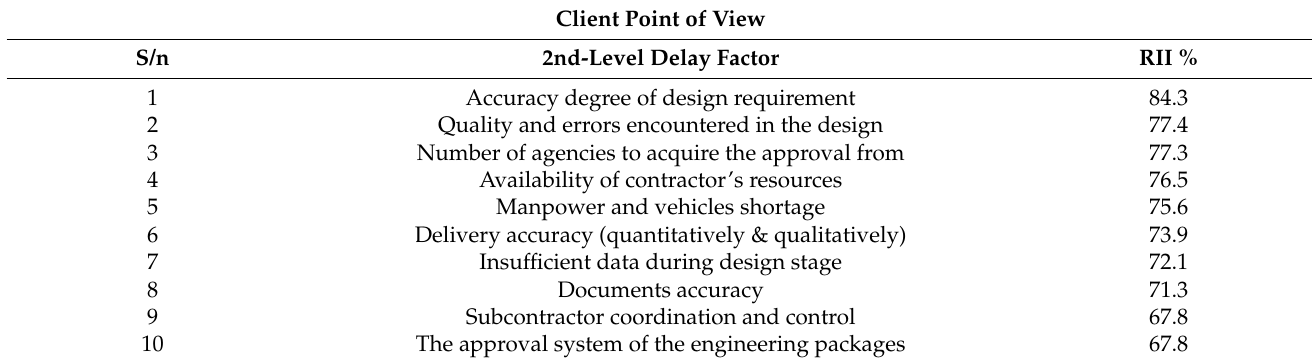
Table 10. Root cause in client point of view.